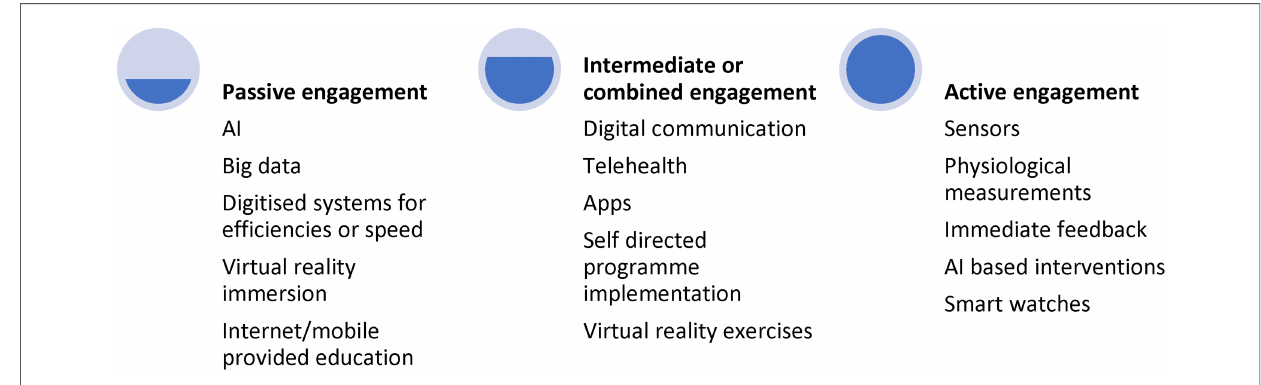
FIGURE 1 Levels of engagement required from patients in digital health